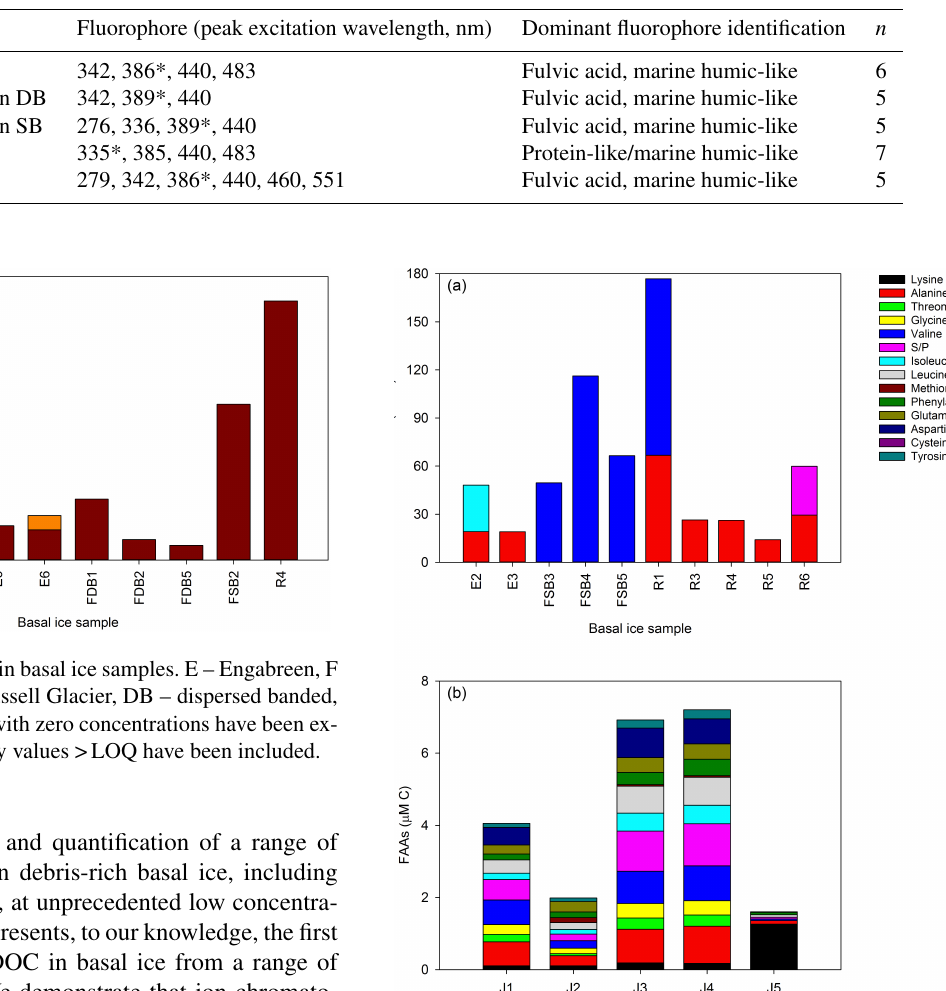
Table 3. Summary of the dominant fluorophores in basal ice from four contrasting glacial environments. The dominant fluorophores (denoted by an asterisk) have been identified according to previous characterization of spectral compounds (see Barker et al., 2009, and references therein). DB – dispersed banded, SB – solid banded.